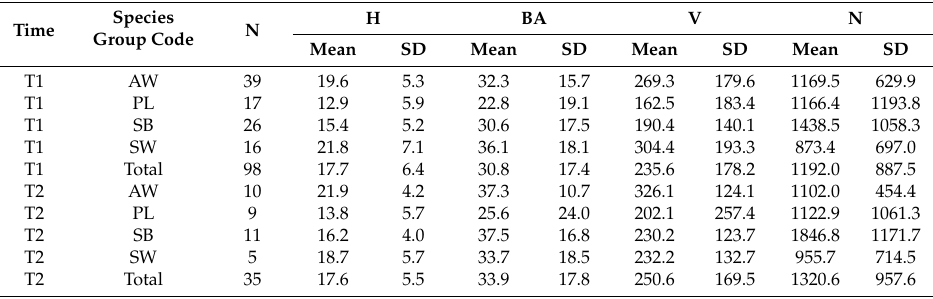
Table 2. Characteristics of permanent sample plots (PSPs) used to generate area-based models of forest stand attributes.